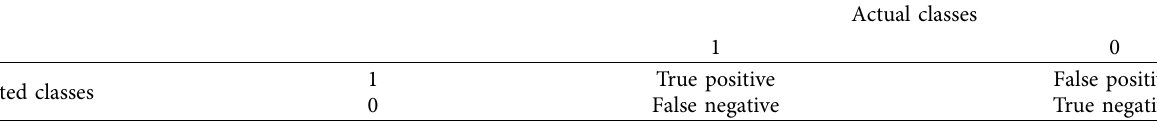
Table 6: Confusion matrix.